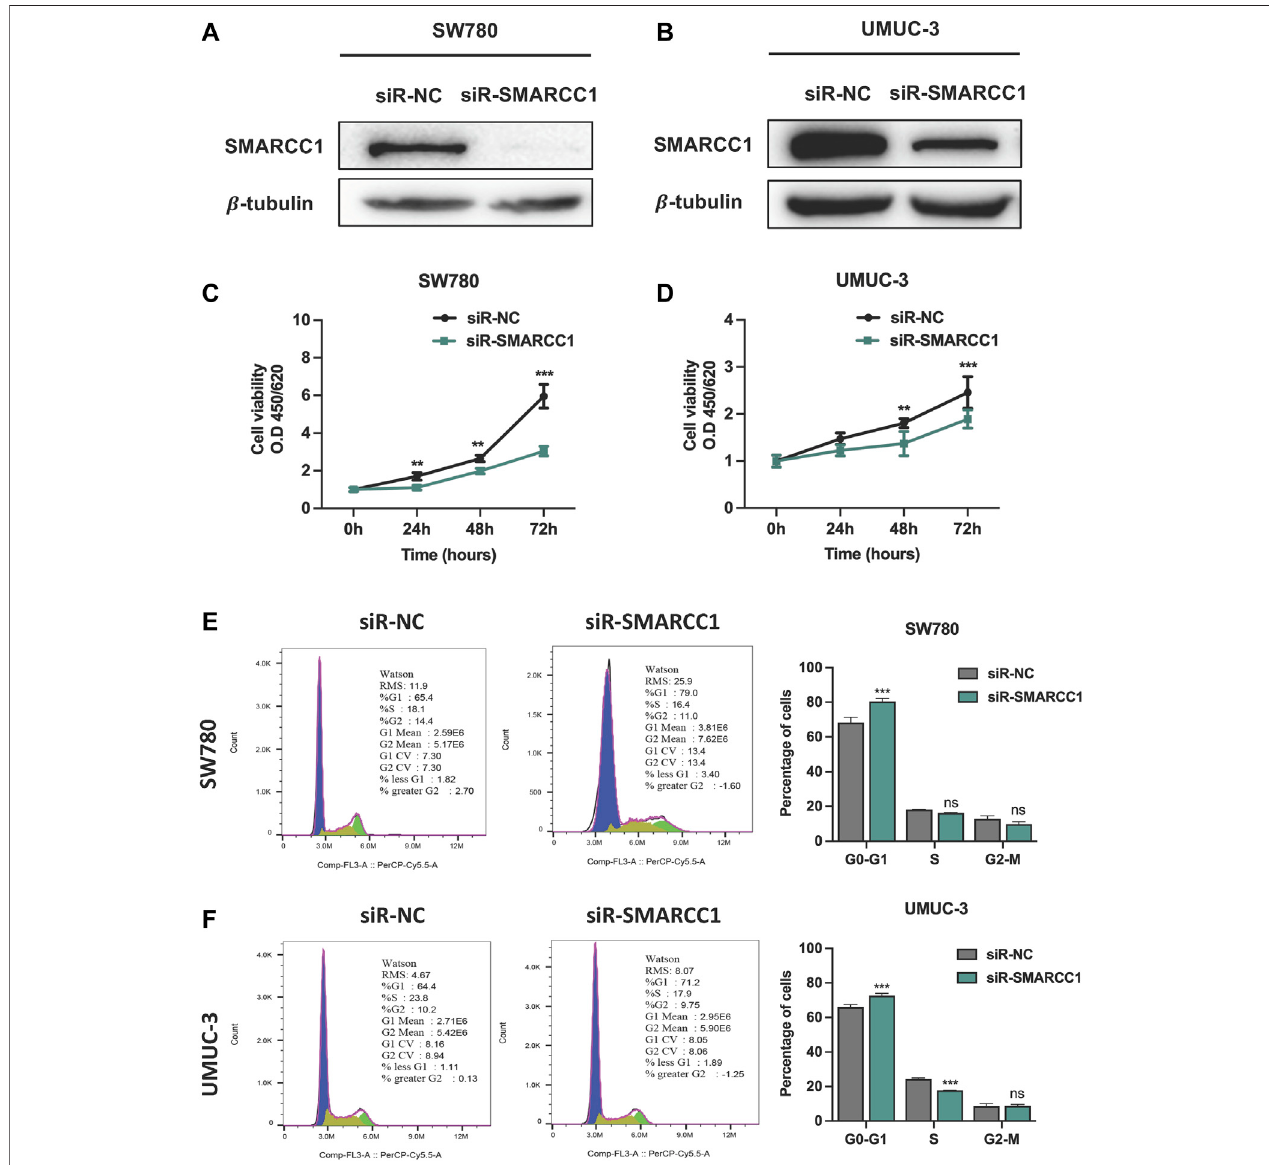
FIGURE 4 | Knockdown of SMARCC1 inhibited cell proliferation and induced cell cycle arrest in G0/G1. (A – B) The western blot results indicated that speci fi c siRNAs for SMARCC1 signi fi cantly decreased the expression of SMARCC1 in both SW780 and UMUC-3 cells. (C – D) Cell proliferation was evaluated using a CCK-8 assay.TheproliferationofSW780andUMUC-3cellswassuppressedaftertransfectionwithsiR-SMARCC1. (E – F) Flowcytometryanalysisindicatedthatknockdownof SMARCC1 induced cell cycle arrest in G0/G1 phase. * p < 0.05, ** p < 0.01, *** p <